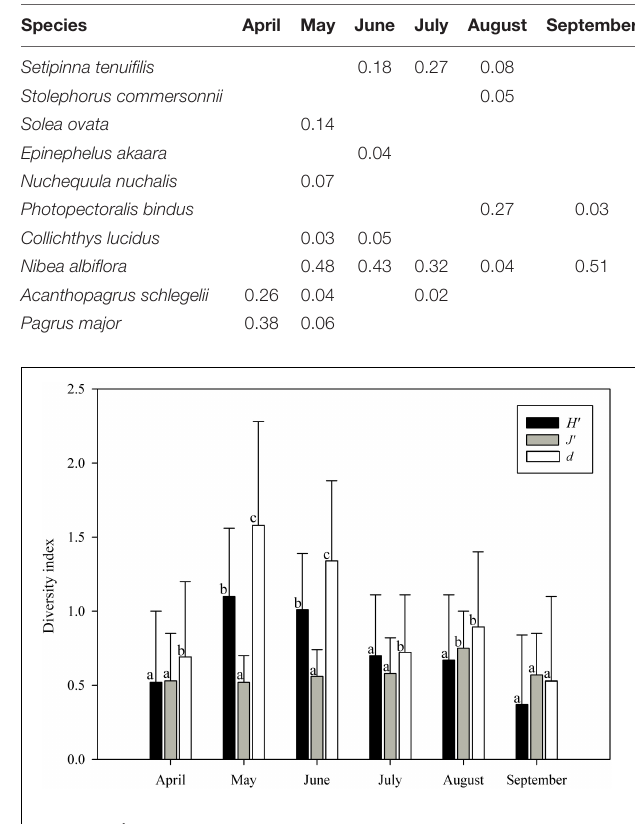
FIGURE 2 | Temporal variation of the three ichthyoplankton diversity indices (mean + standard deviation [SD], n = 25 stations) from April to September 2019 in Sansha Bay. H (cid:48) , Shannon-Wiener diversity index; J (cid:48) , Pielou’s evenness index; d , Margalef’s richness index. Values with different letters (a–c) indicate the significant difference at p ≤ 0.05 among months, and values with the same letter indicate that the difference was not significant at p >